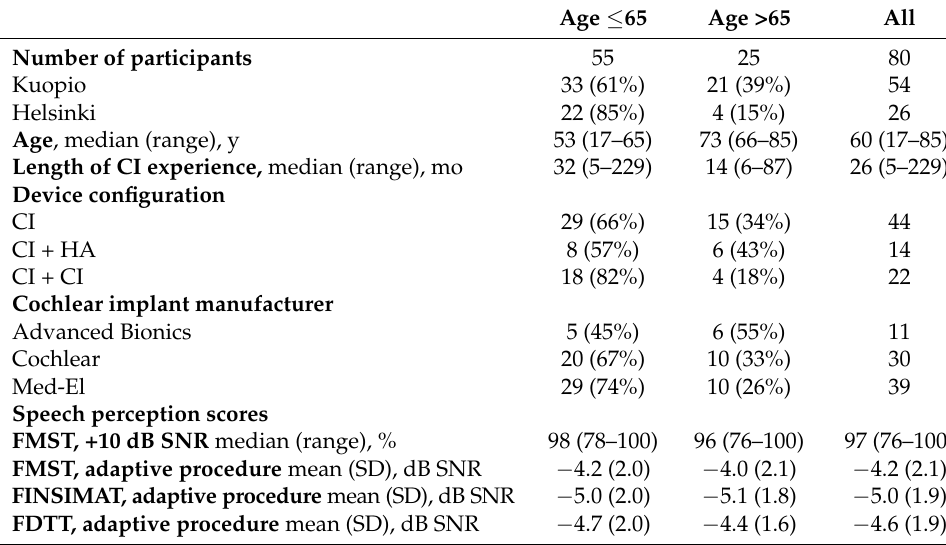
Table 2. Summary of the demographics and test results of the participants.